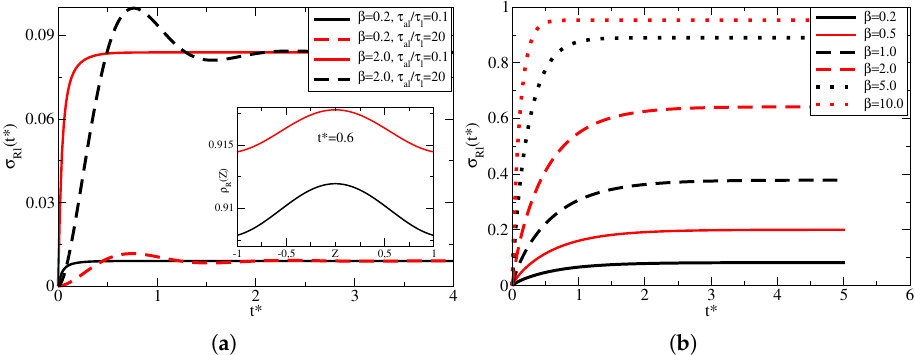
Figure 2. Role played by the parameter β = ρ 0 d / σ 0 on the surface dynamics. ( a ) shows the left surface ( Z = − 1) vs. t ∗ for τ D / τ l = 100, τ κ l / τ l = 10 and for two values of τ al / τ l , that is, 0.1 or 20 and β = 0.2 and β = 2. The inset shows the bulk density ρ R vs. Z when t ∗ = 0.6 for β = 2 (in red) and β = 0.2 (black). ( b ) shows the left surface ( Z = − 1) vs. t ∗ for τ D / τ l = 100, τ κ l / τ l = 1, and τ al / τ l = 0.1 for several values of the parameter β